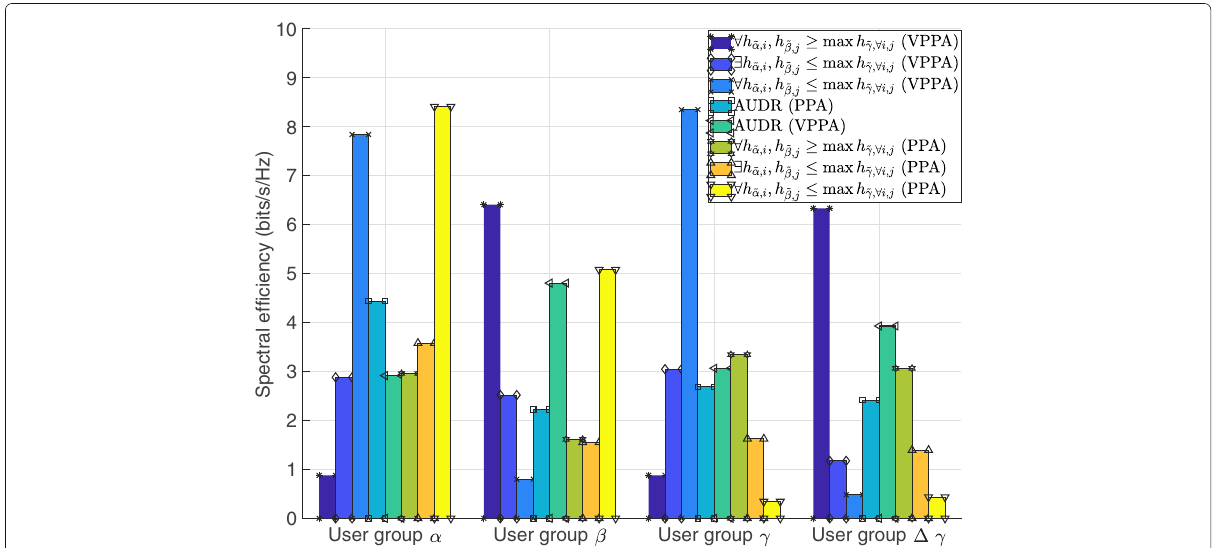
Fig. 5 Spectral efficiency of each user group with (cid:5) 1 / 2 = 30 ◦